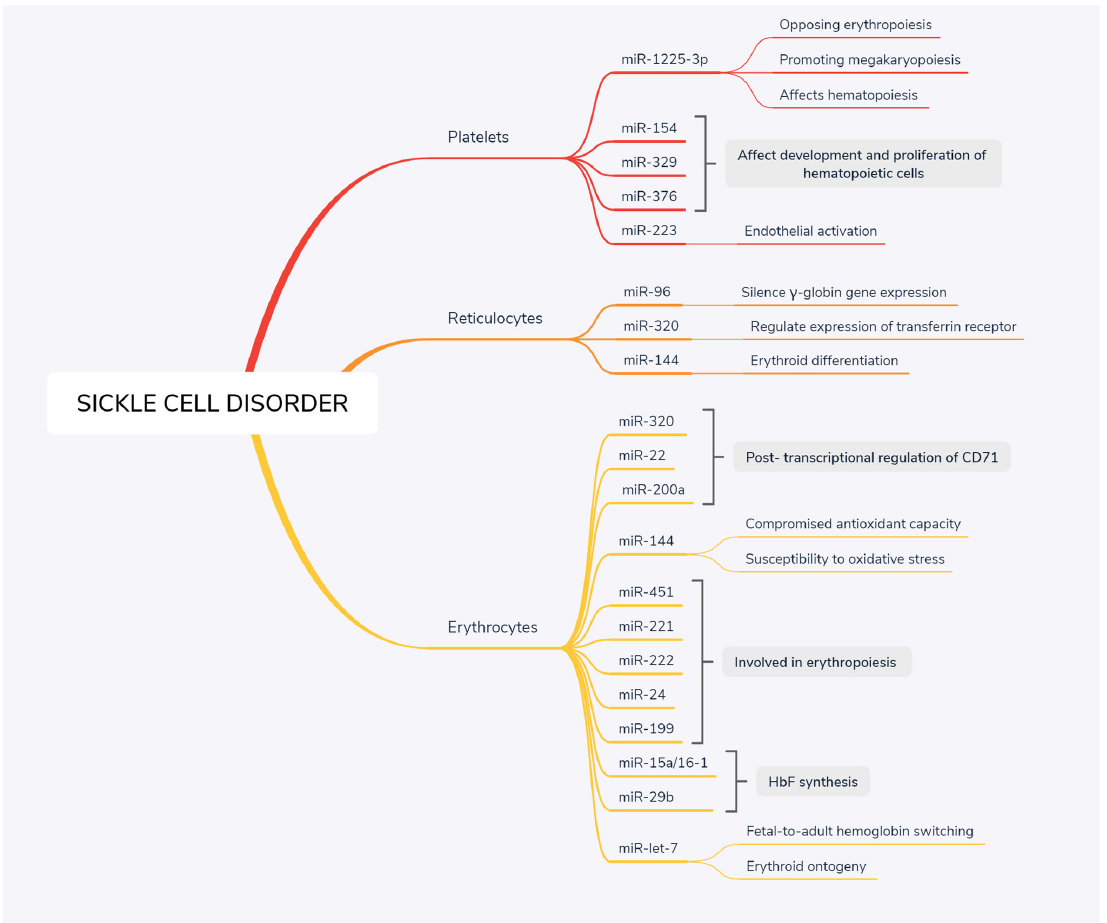
Figure 1. Several key miRNAs associated with sickle cell disease. miRNAs that are specific to erythrocytes, reticulocytes and platelets with dysregulated expression associated with disease manifestation are depicted.